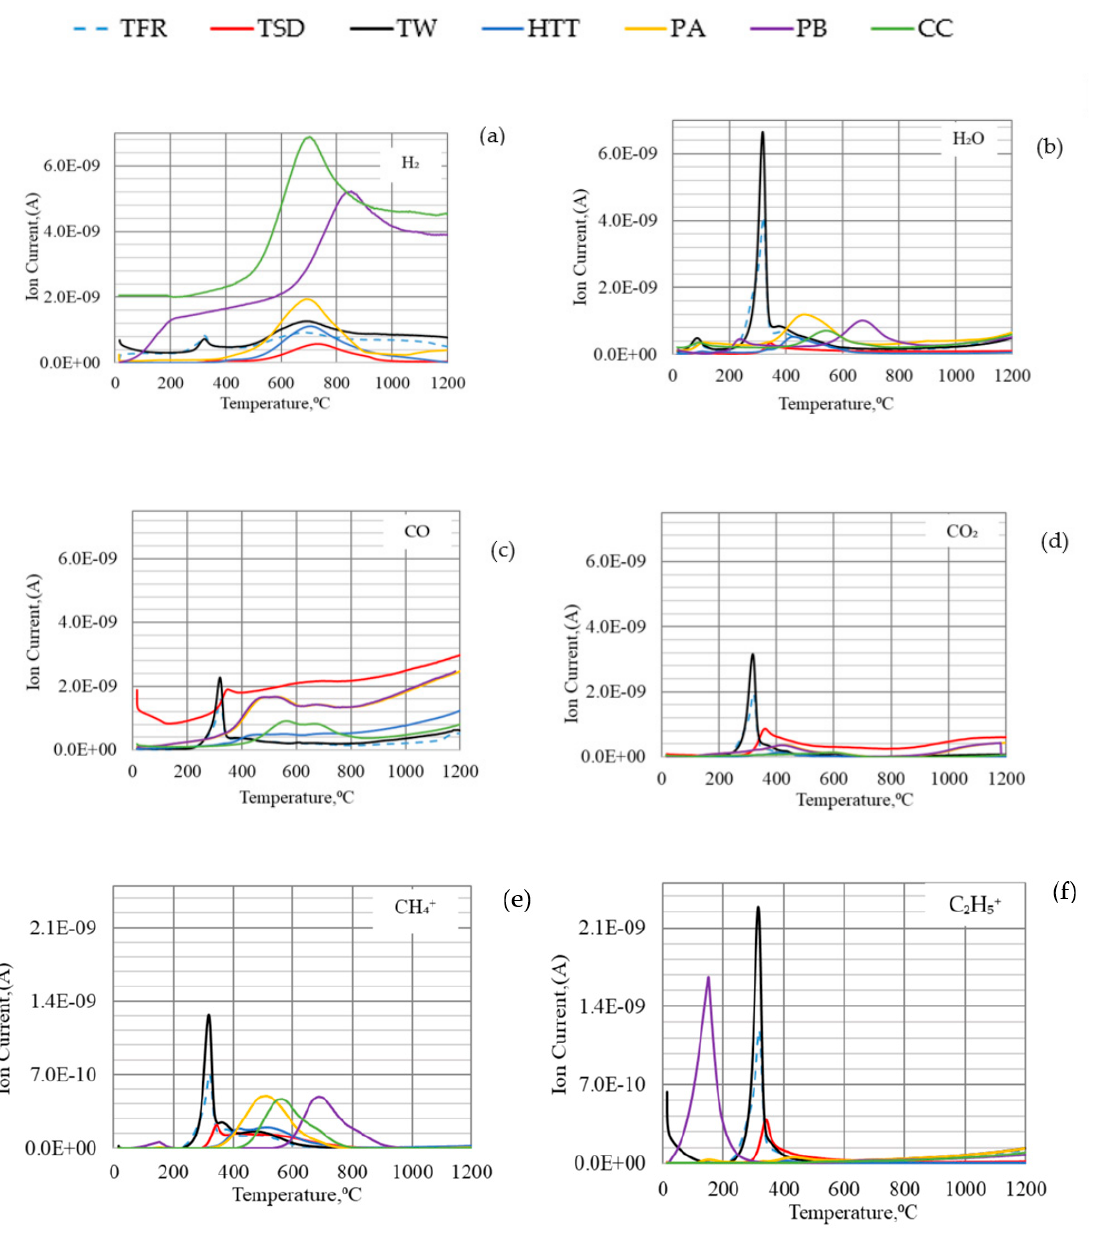
Figure 6. Off-gas analysis of ( a ) H 2 ; ( b ) H 2 O; ( c ) CO; ( d ) CO 2 ; ( e ) CH 4+ ; ( f ) C 2 H 5+ for different types of bio-coals.